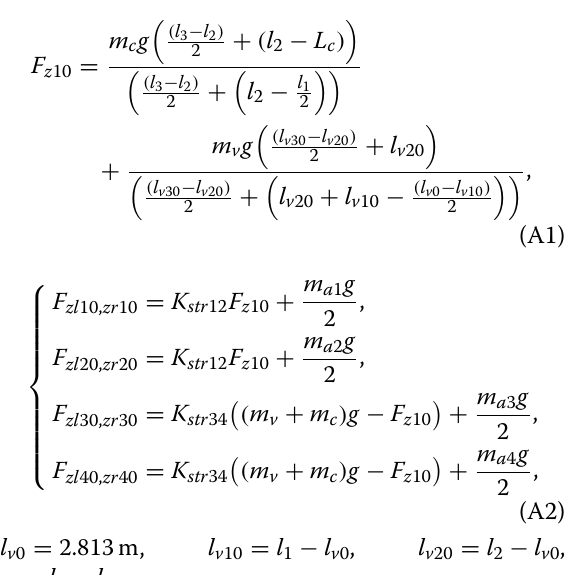
Angle from Estimation without Initial Parameters Update and Noise Roll Angle from Trucksim